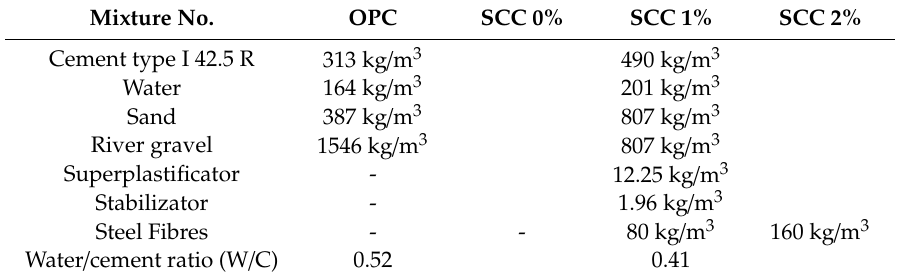
Table 1. The concrete mixtures components [31] based on from Ordinary Portland Cement (OPC) and Self ‐ Compacting Concrete (SCC) with steel fibres.